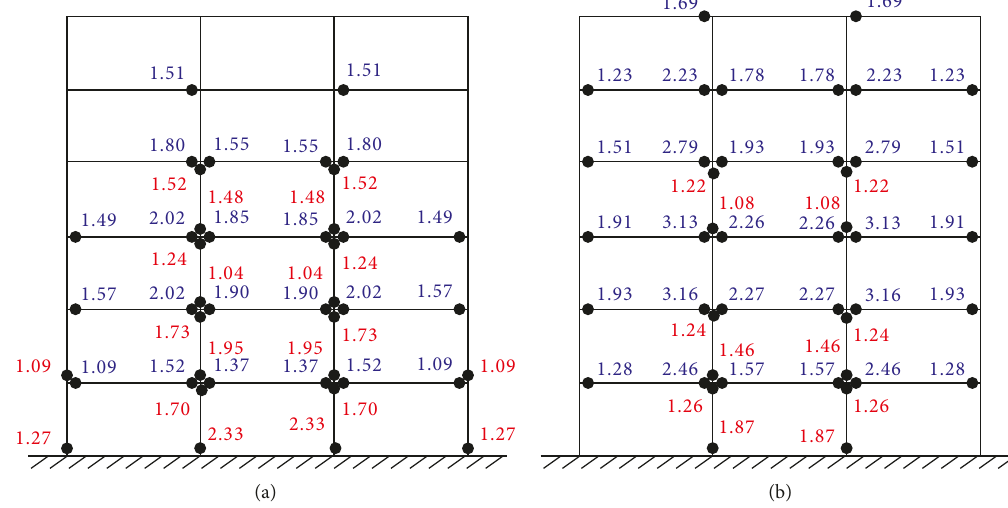
Figure 21: Plastic hinge distribution with 8-degree (0.30 g) fortification intensity. (a) Considering the beam-to-column linear stiffness ratio limit values. (b) Not considering the beam-to-column linear stiffness ratio limit values.